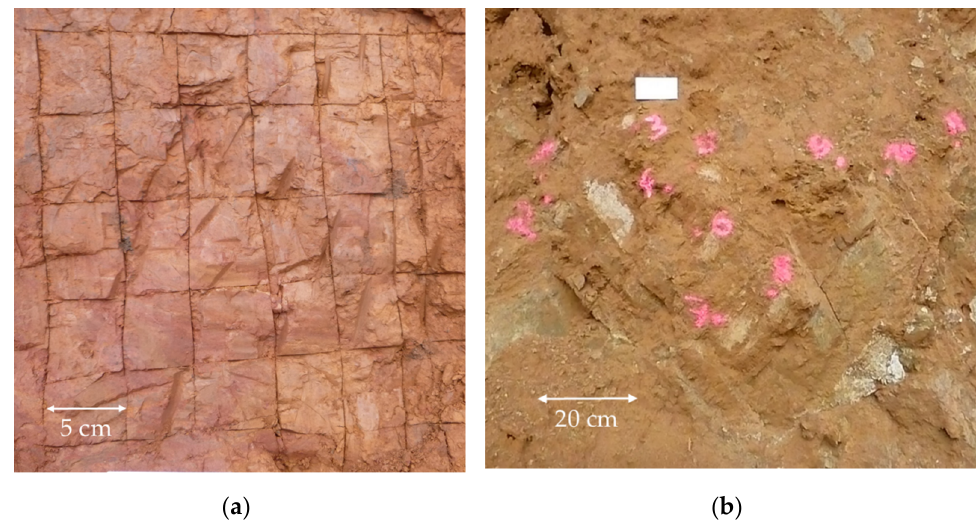
Figure 5. Two sampling processes depending on panel humidity and cohesion: ( a ) a 5 × 5 grid in a limonitic panel; ( b ) random sampling in a saprolitic panel.